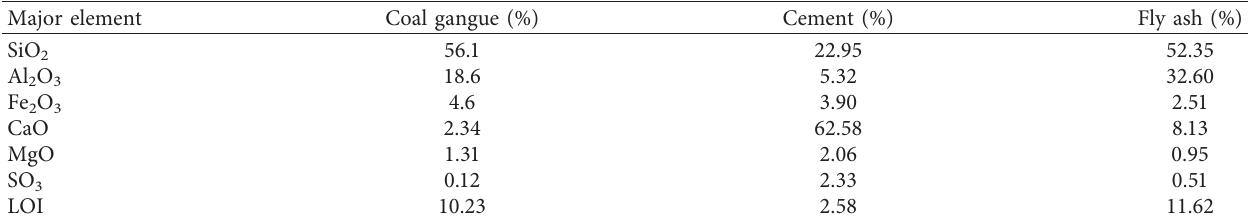
Table 1: Chemical composition of the main raw materials of backfill specimen.